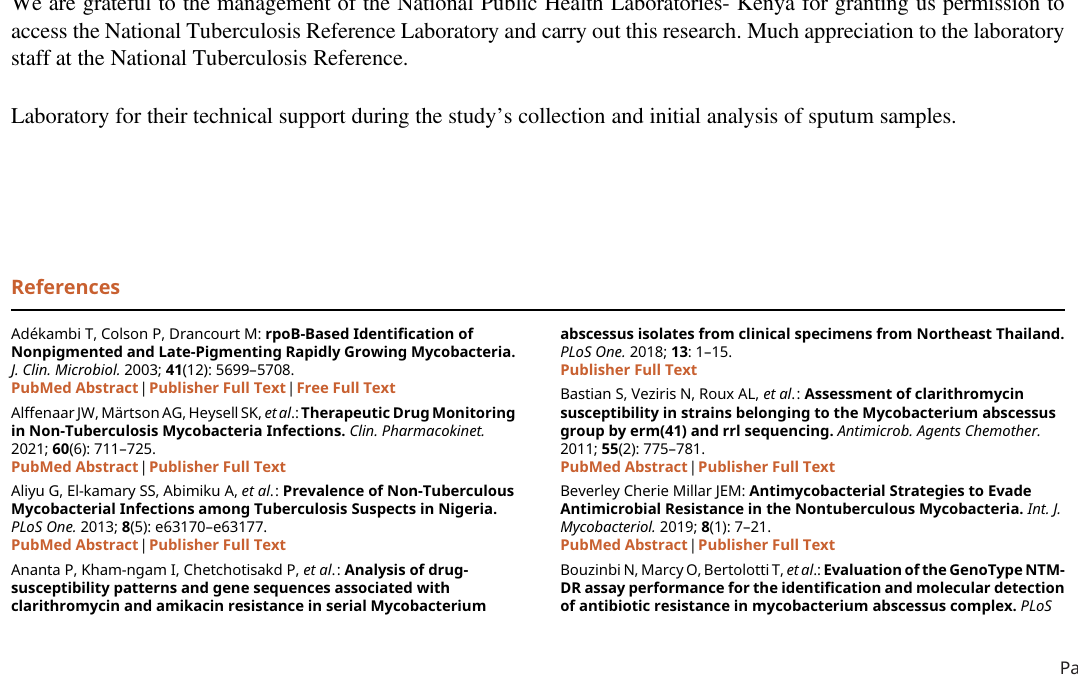
Figshare. Mutation Patterns of Resistance Genes for Macrolides, Aminoglycosides, and Rifampicin in